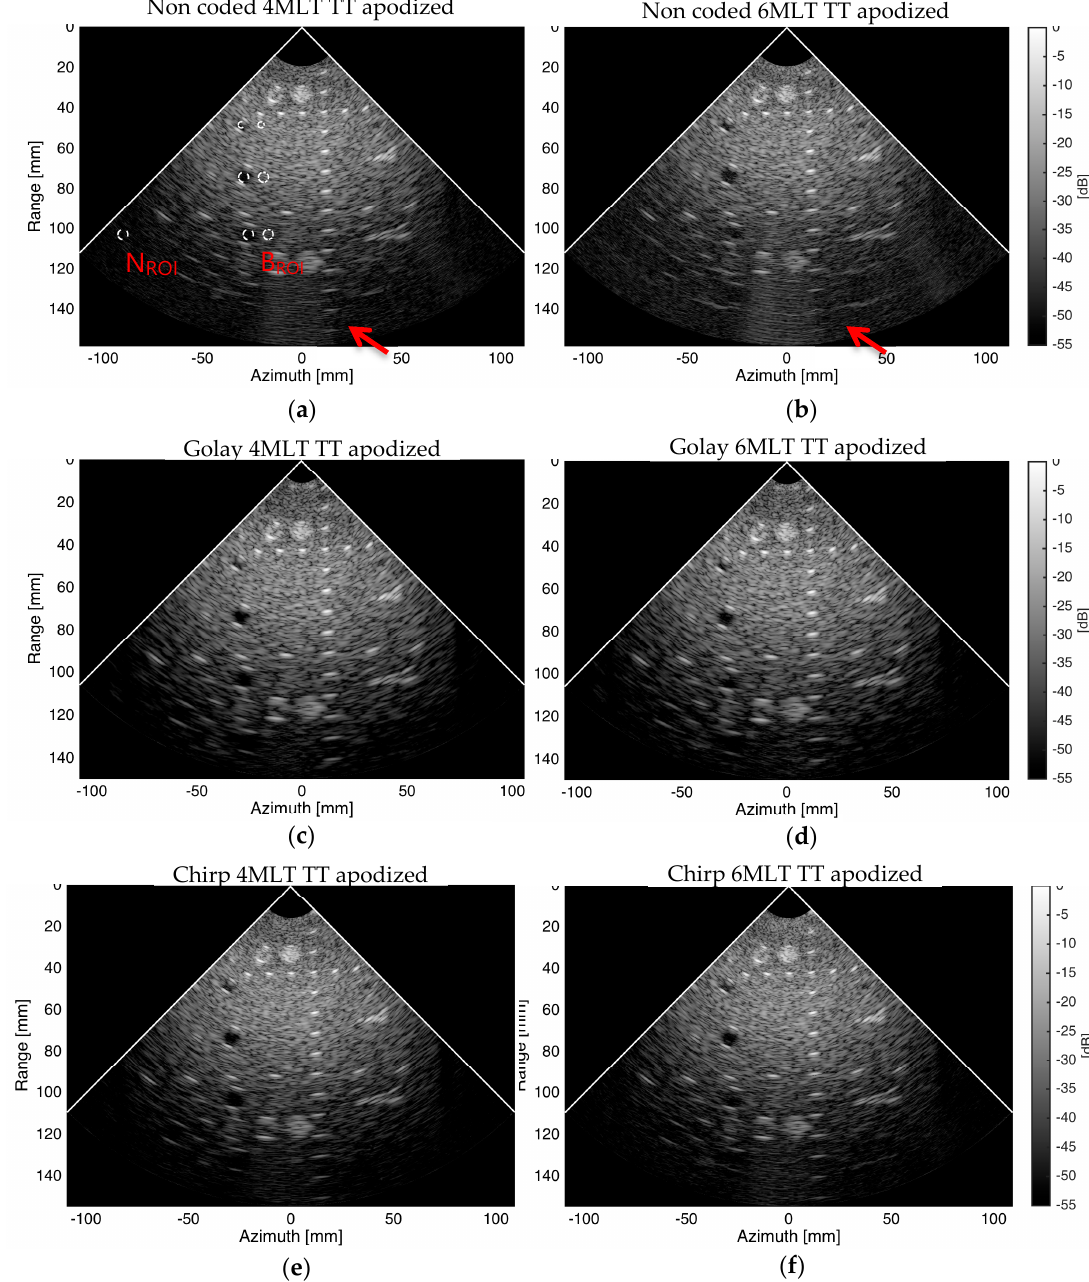
Figure 11. Tissue phantom images of the 4MLT and 6MLT schemes using ( a , b ) non-coded; ( c , d ) Golay-coded excitation; or ( e , f ) chirp-coded excitation. TT apodization was applied on both transmit and receive. TT: Tukey ( α = 0.5)-Tukey ( α = 0.5) apodization scheme. A dynamic range of 55 dB was used. The arrows in panel ( a ) and ( b ) point the areas in which the non-coded MLT schemes started to lose signal-to-noise ratio (SNR).